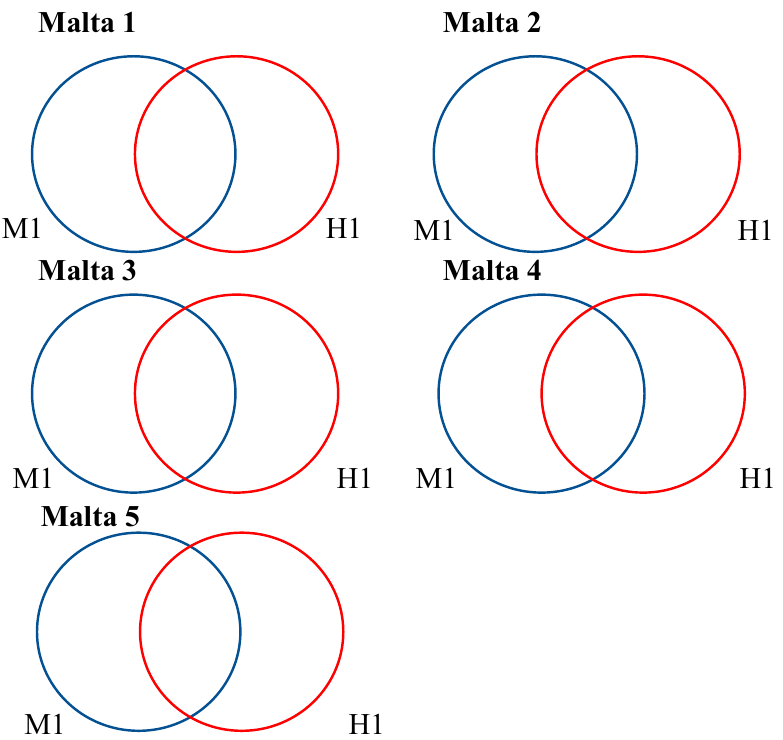
Figure 2. Comparison between the Eco RI- Msp I and Eco RI- Hpa II profiles of each sample. The numbers represent the genes identified from the contigs vs. A. thaliana. The list of private or shared genes is reported in Archive S1B.